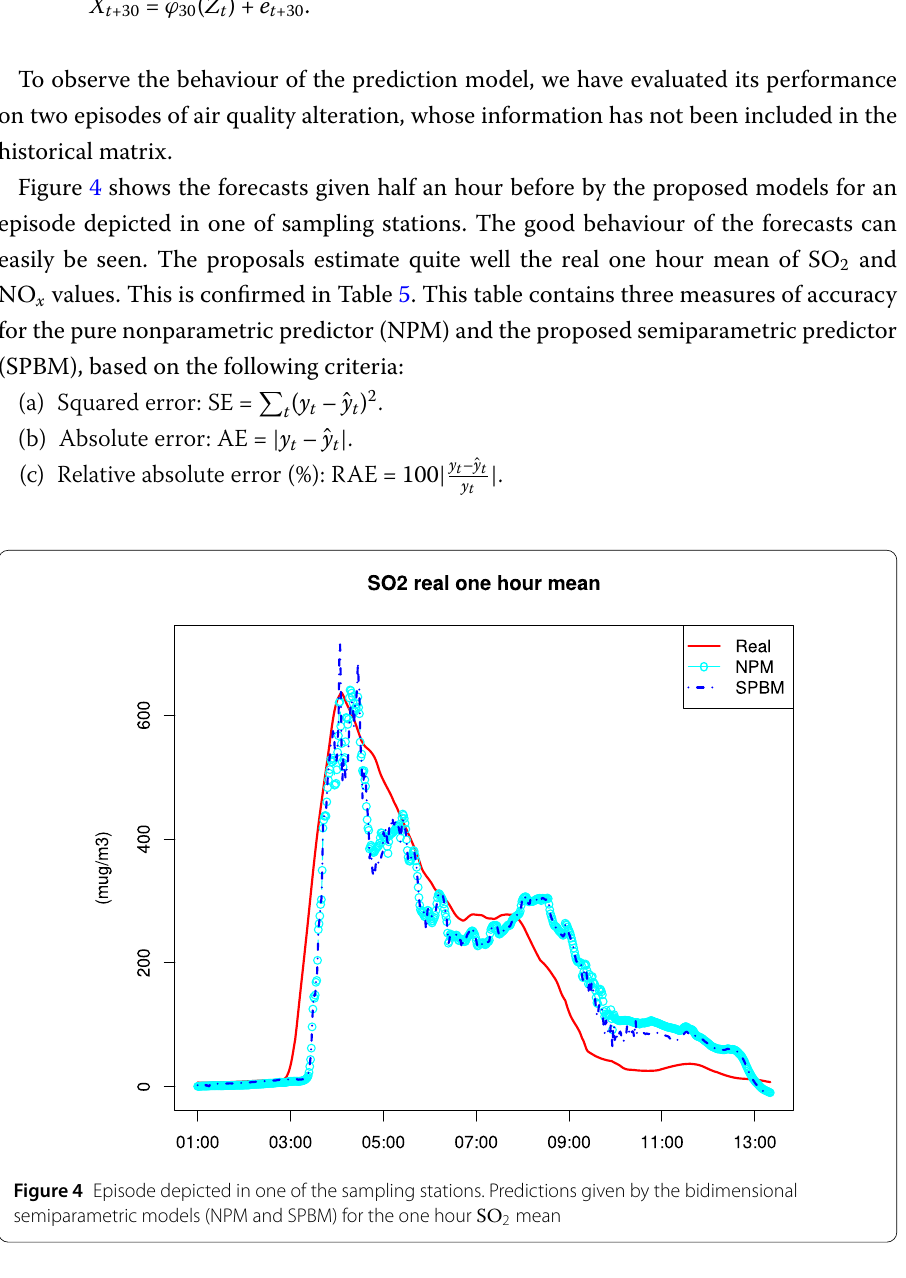
Table 5 SO 2 and NO x Forecast errors